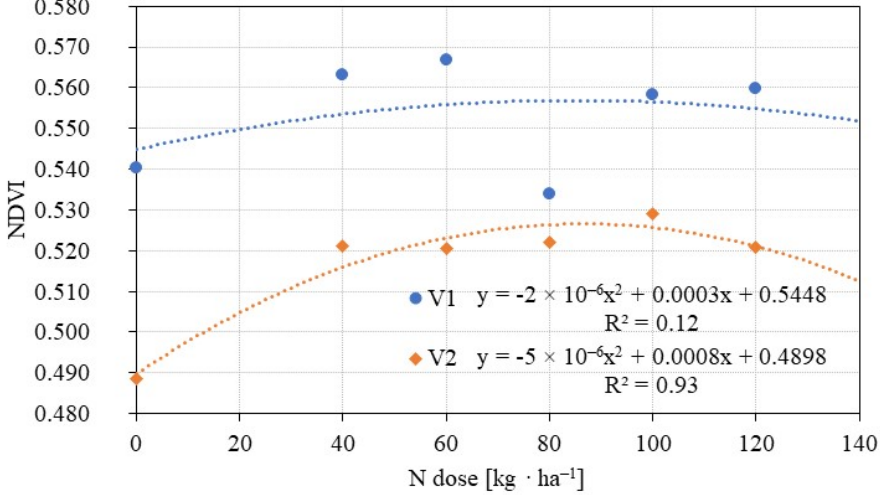
Figure 7. NDVI prior to application of nitrogen fertilization (19 March 2020)—BBCH 29.